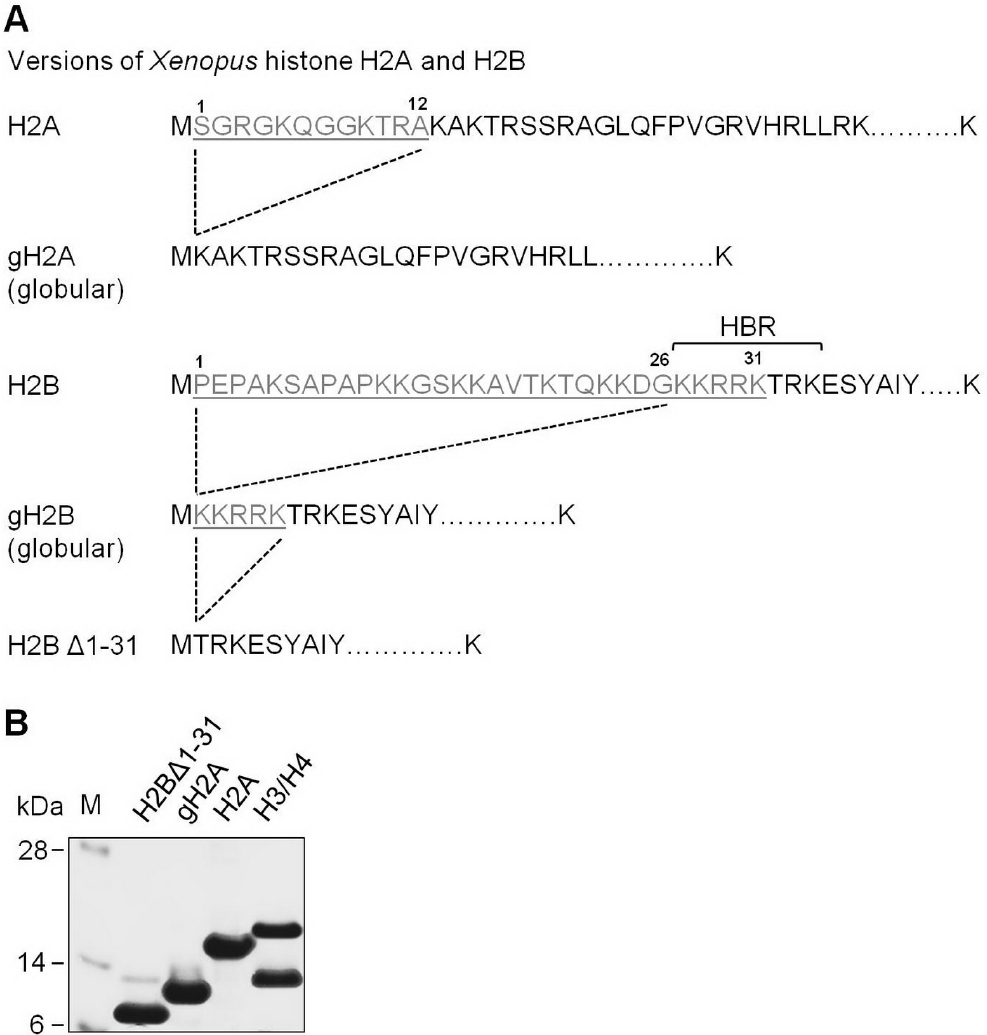
Figure 1. Experimental system. ( A ) Partial amino acid sequences of intact and mutant versions of histones H2A and H2B used in this work. HBR region of histone H2B is indicated. ( B ) Analysis of purified proteins by SDS-PAGE (staining with Coomassie). M: molecular mass markers.